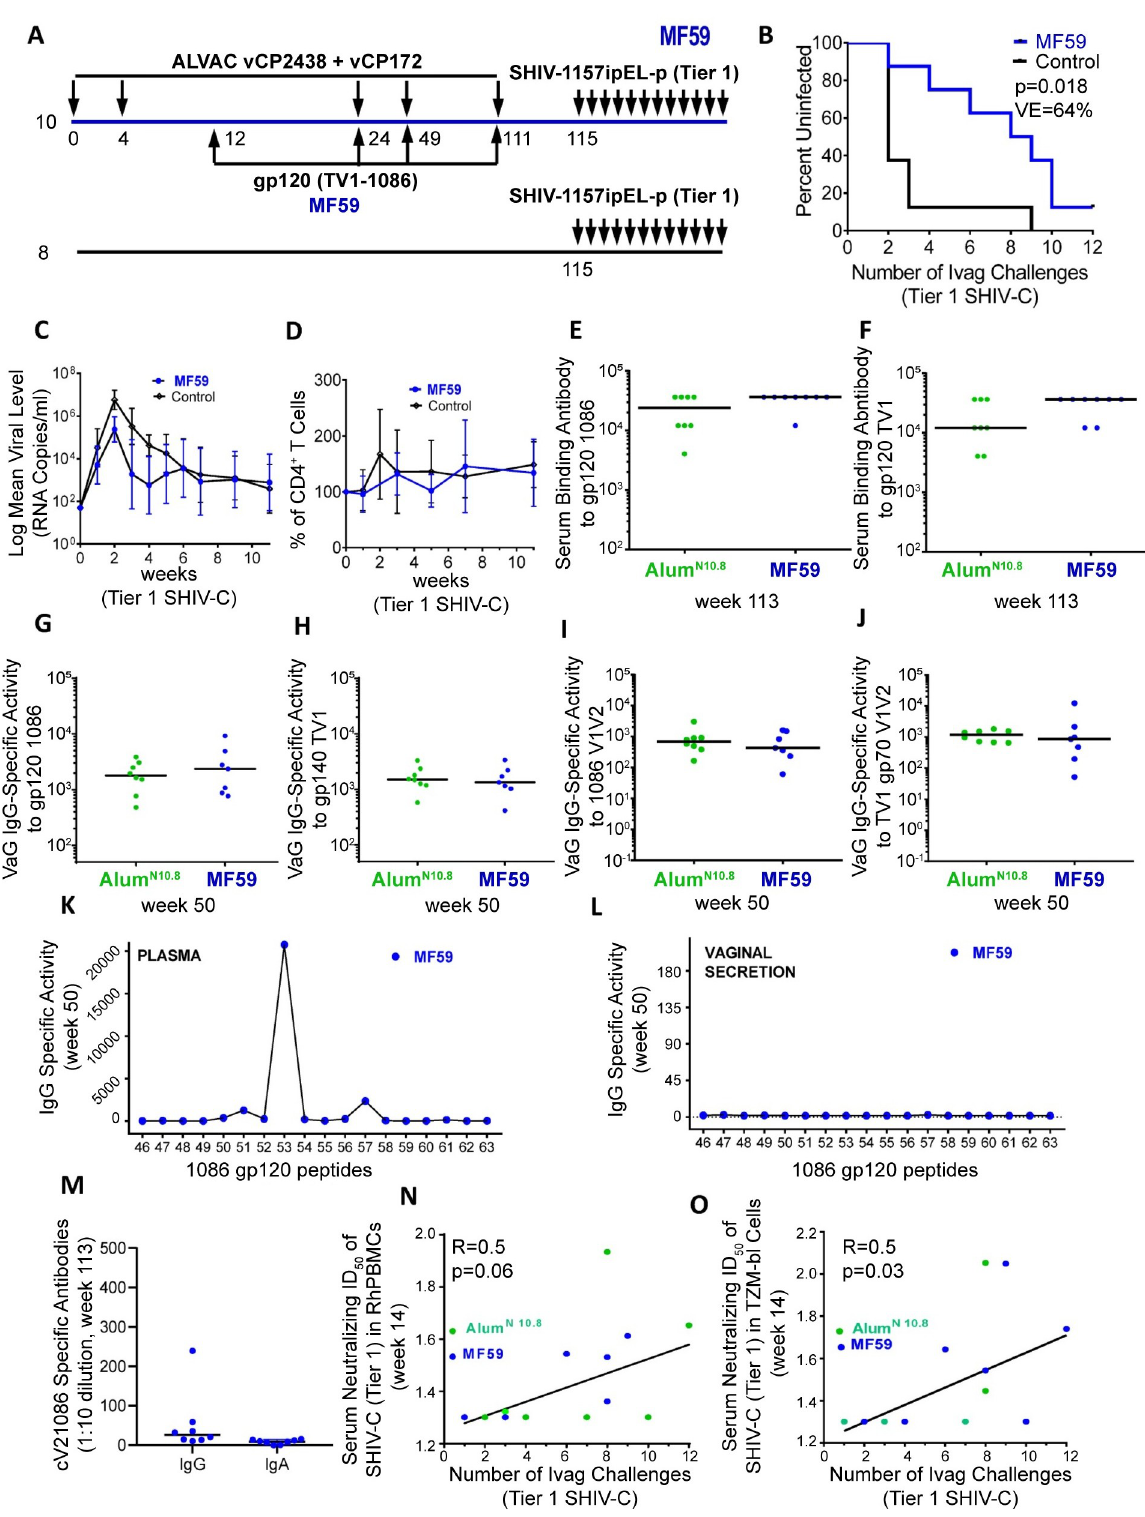
Fig 3. Relative efficacy and immunogenicity of the MF59 regimen. Unless stated otherwise, all assays, experiments and graphs associated with the MF59 study are represented by full blue circles, those of the Alum N10.8 study are represented by full green circles, and only available samples (i.e., those not depleted in other experiments) are shown. The number of samples represented in each graph is stated below. (A) Animals were